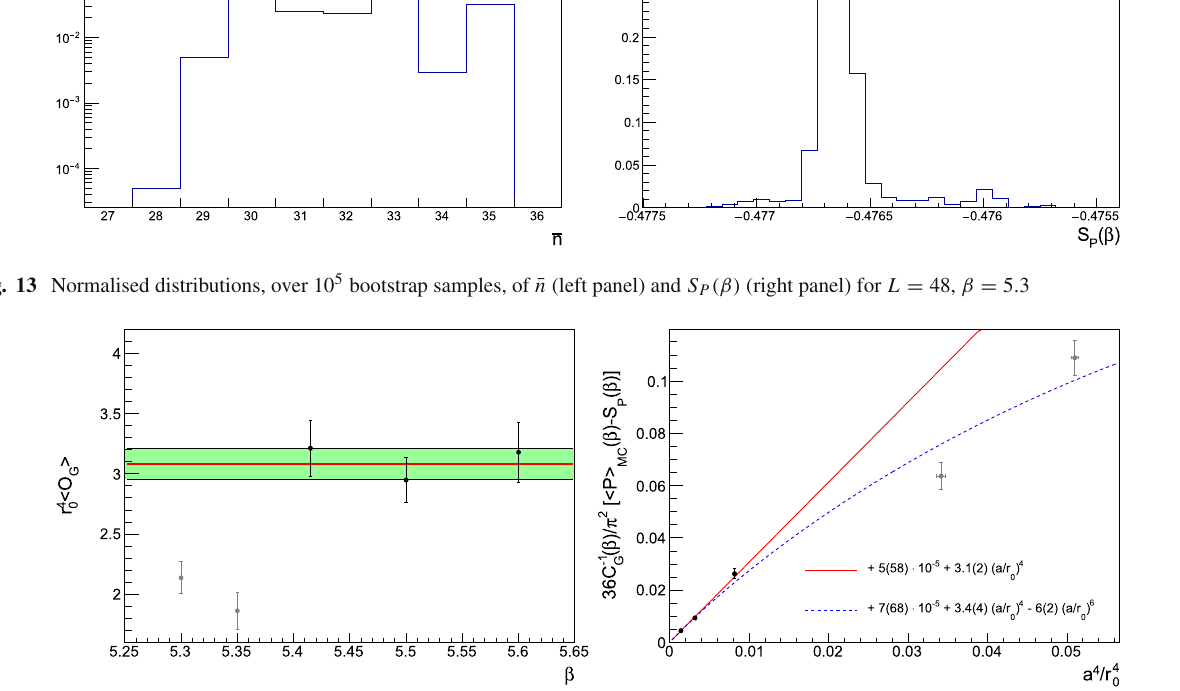
Fig. 14 In the left panel, determination of the gluon condensate from Eq. (62). The line corresponds to the weighted average of the three largest values of β . In the right panel, scaling of the condensate with a 4